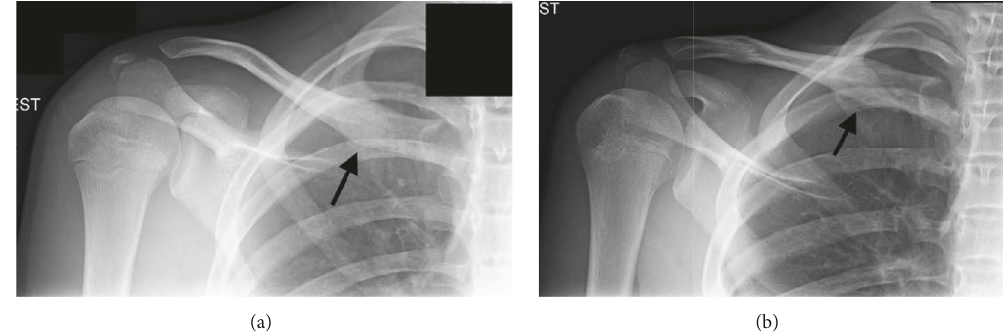
Figure 3: (a) Postoperative AP view and (b) AP cephalic tilt view of the right medial clavicle. The black arrow indicates the site of fracture.